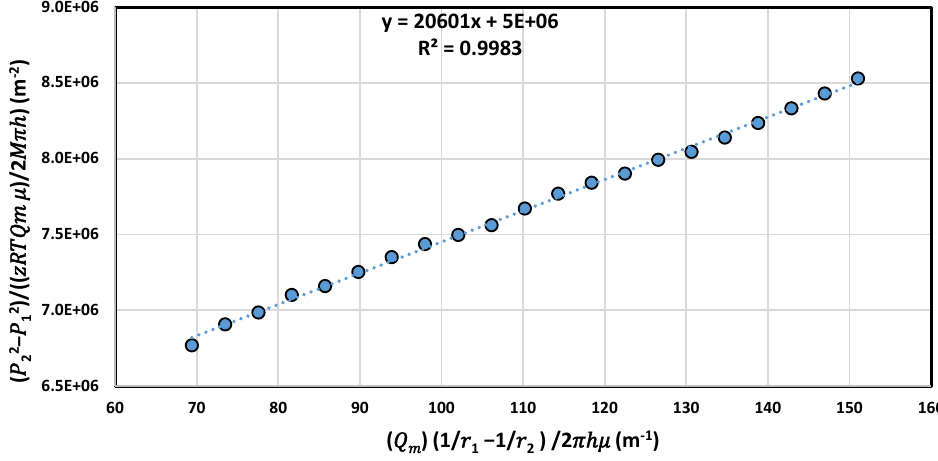
Figure 6. Calculating the non-Darcy β . Permeability = 12 Darcy .